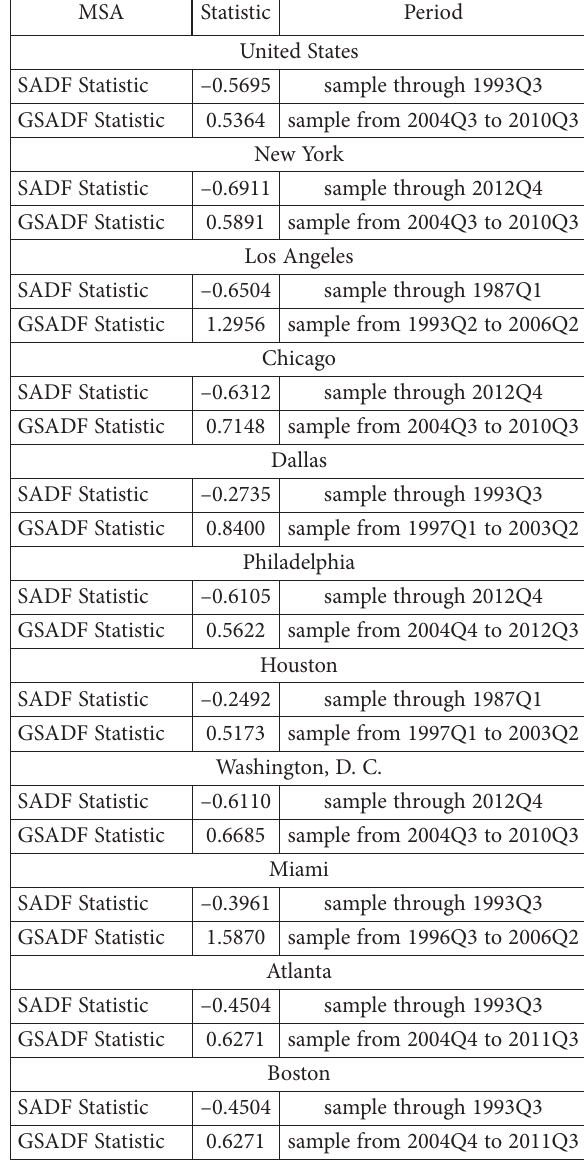
Table 6. Results of SADF and GSADF tests (the ratio of